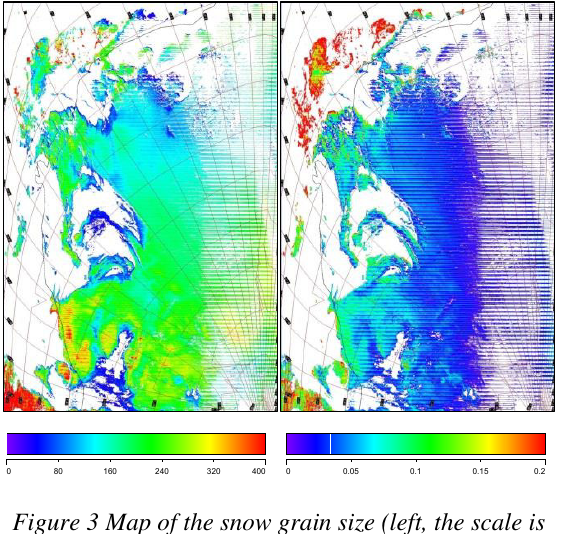
Figure 3 Map of the snow grain size (left, the scale is in micrometers) and rock fraction (right) retrieved from the MODIS-Terra data (January 01, 2015,